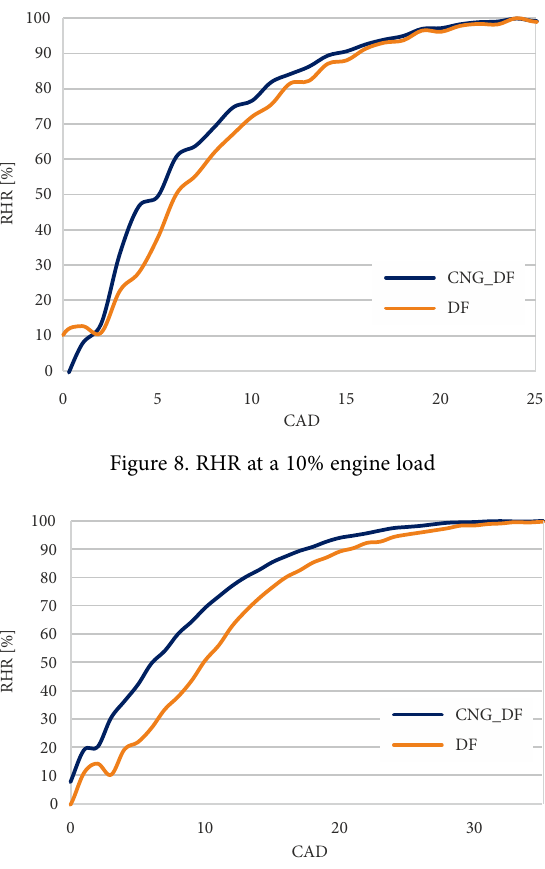
Figure 10. RHR at a 75% engine load Figure 11. RHR at a 100% engine load